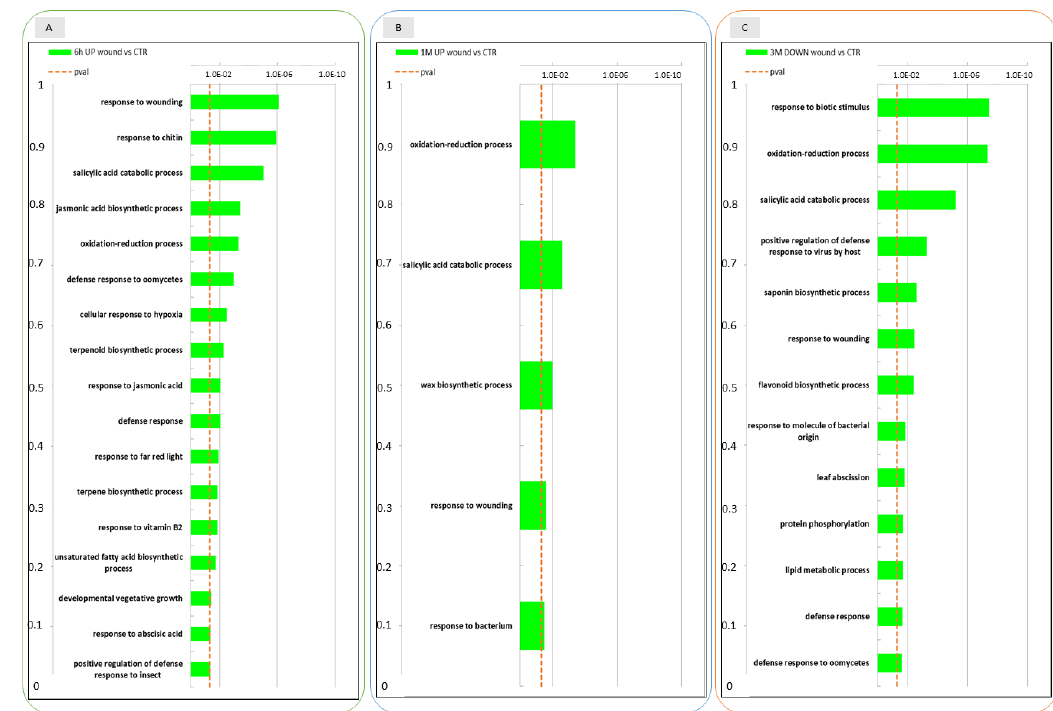
Figure 3. Enrichment analysis of DEGs using the Gene Ontology database. GO categories overrepresented among up- and down-regulated gene sets in the wounded apple skin in comparison to non-wounded control skin at three time points 6 h after wounding (6 h), 1 month (1 M) and 3 months (3 M) of conservation. The data refer to samples collected in 2019. In panel A GO categories are shown for genes that were upregulated in the comparison between wound and control at 6 h; panel B: GO categories of genes upregulated in the comparison between wound and control at 1 M; panel C: GO categories of genes that were downregulated in the comparison between wound and control at 3 M.